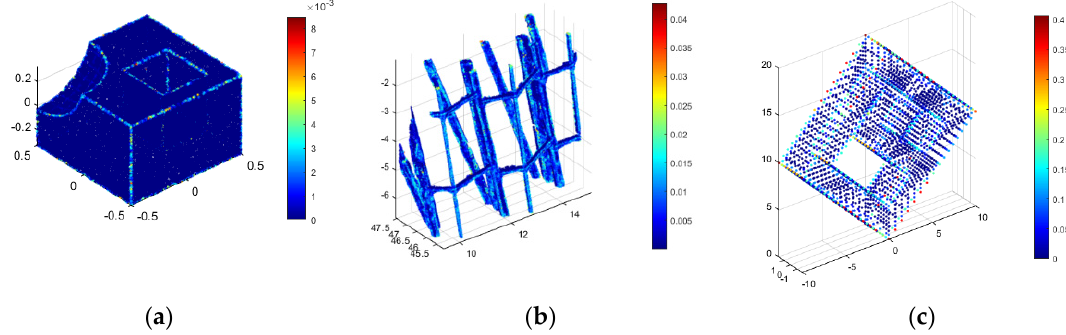
Figure 10. 𝑃 (cid:3031) values for different tested point clouds: ( a ) sample object 1, ( b ) sample object 2, ( c ) sample object 3.